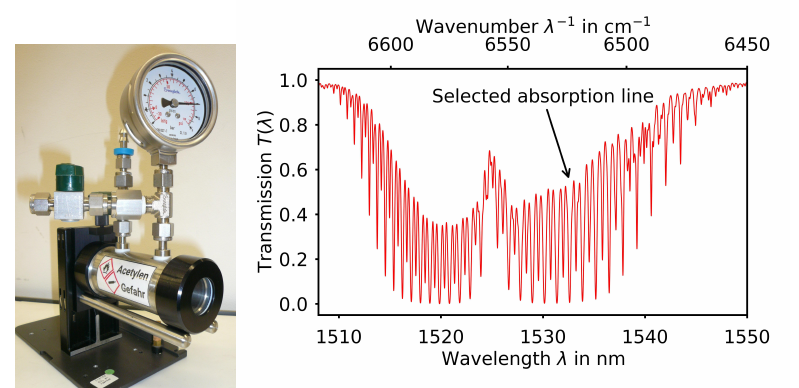
Figure 2. Left : High pressure absorption cell for the measurements; right : Conventionally measured standard absorption spectrum of acetylene around 1530nm with an absorption length of 10cm and an absolute pressure of